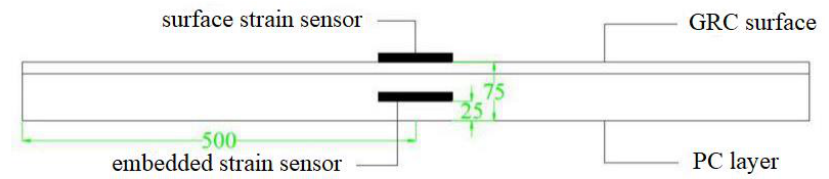
Figure 7. Strain sensor location in the composite wall panel.